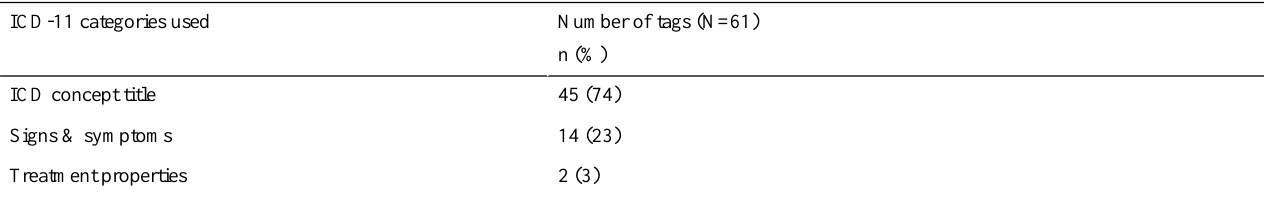
Table 3. Distribution of tags over ICD-11 categories (for the cardiology